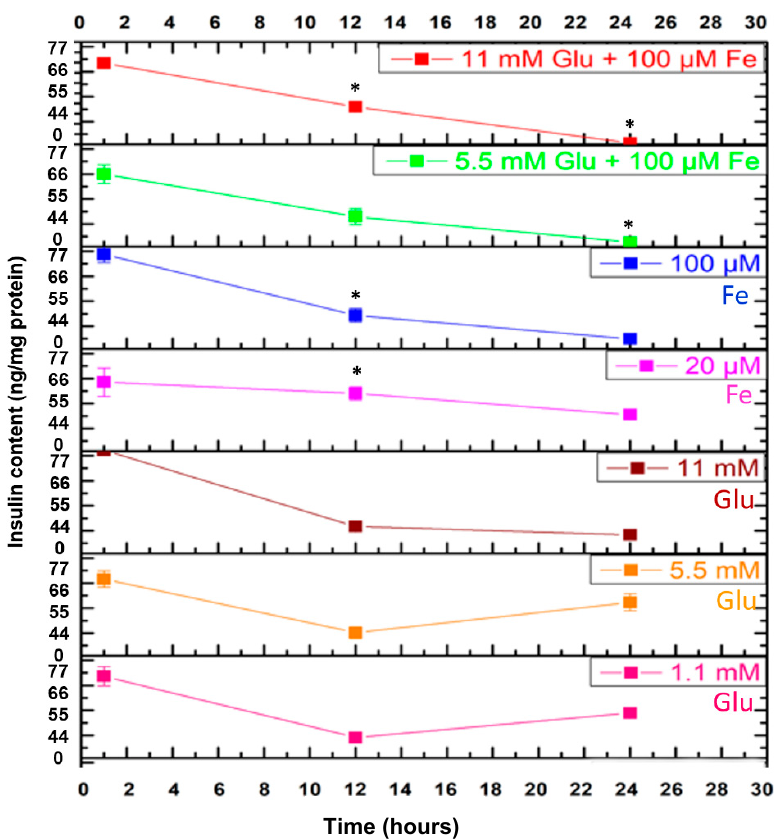
Figure 6. The effect of iron and glucose on intracellular insulin content. Measurements were performed using insulin ELISA in cultured cells. MIN6 cells were exposed to various concentrations of iron, glucose, and combinations of iron and glucose with the addition of tolbutamide at designated incubation times. The data represent mean ± SEM, n = 3. * p < 0.0193 (20 µ M Fe (C3)—12 h), * p < 0.022 (100 µ M Fe (C4)—12 h), * p < 0.0148 (11 mM Glu + 100 µ M Fe (C8)—12 h); * p < 0.0229 (5.5 mM Glu + 100 uM Fe (C6)—24 h), * p < 0.011 (11 mM Glu + 100 µ M Fe (C8)—24 h). At 24 h incubation, both 20 µ M and 100 µ M iron led to a reduction in insulin content that was not statistically significant (20 µ M Fe: 12.27%; 100 µ M Fe: 10.22%), whereas 5.5